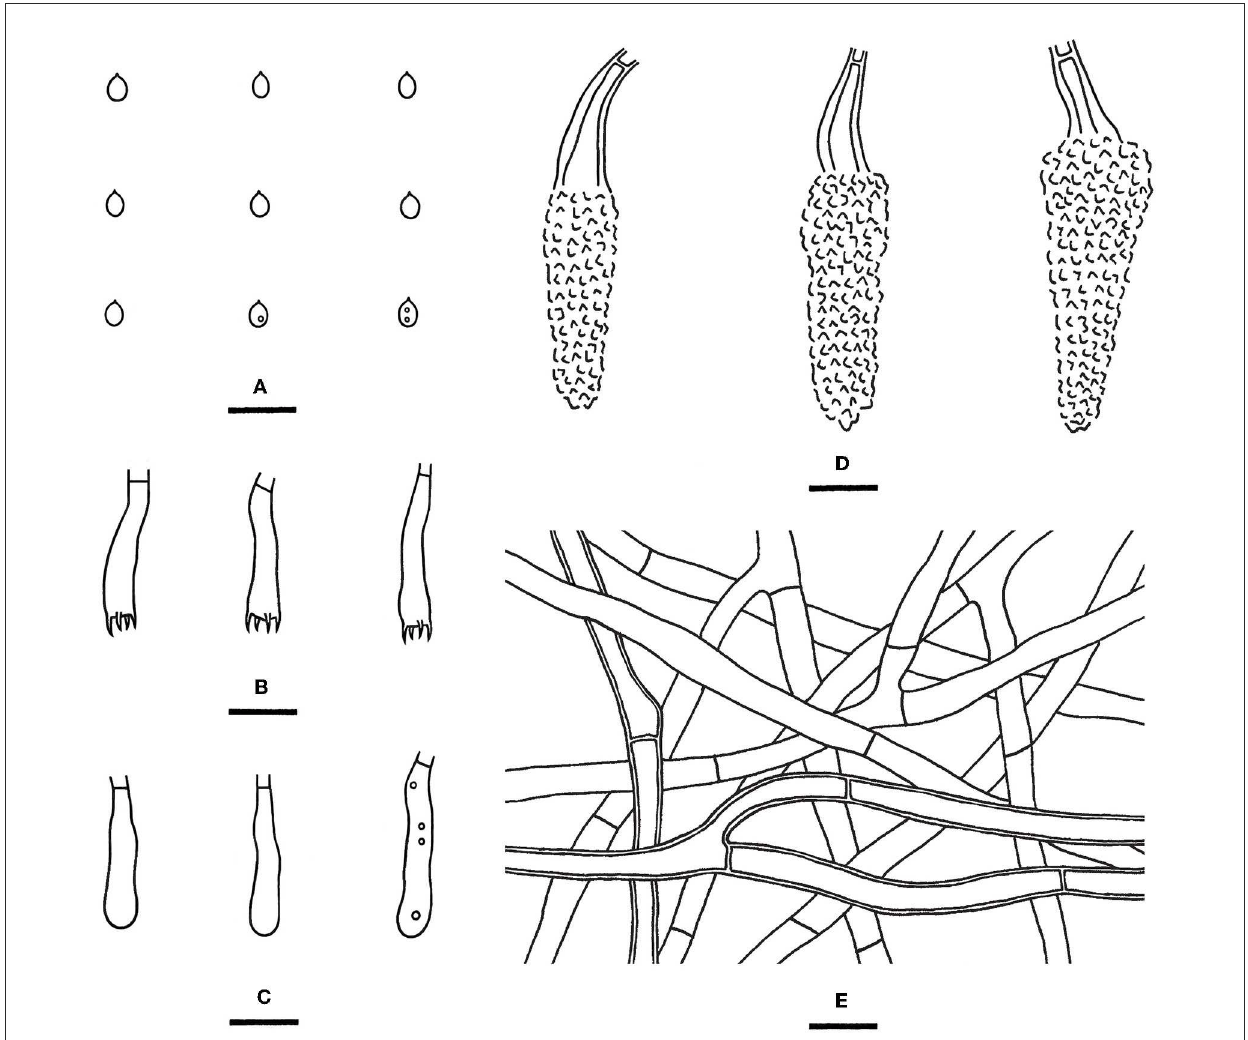
FIGURE9 Rhizochaete nakasoneae [from the holotype He 2291; scale bars: (A–E) = 10 µ m]. (A) Basidiospores; (B) Basidia; (C) Basidioles; (D) Lamprocystidia; (E) Hyphae from